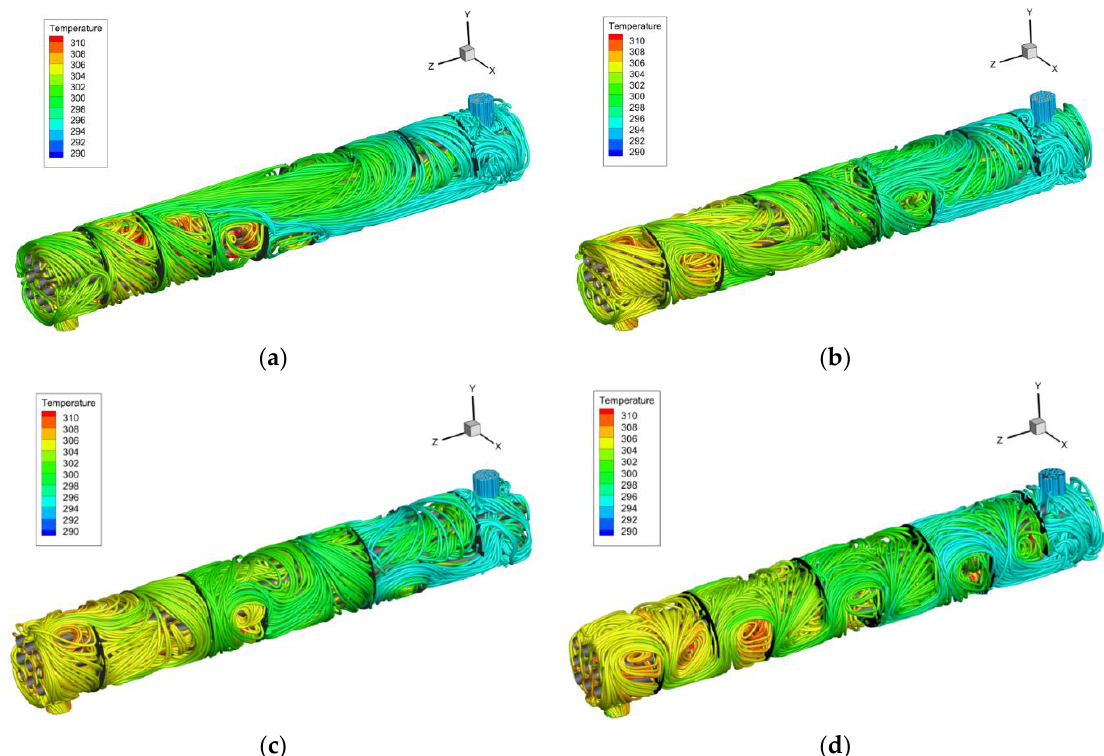
Figure 14. The streamline contour within the heat exchanger with baffle angles of ( a ) 45°, ( b ) 90°, ( c ) 135°, and ( d ) 180°.